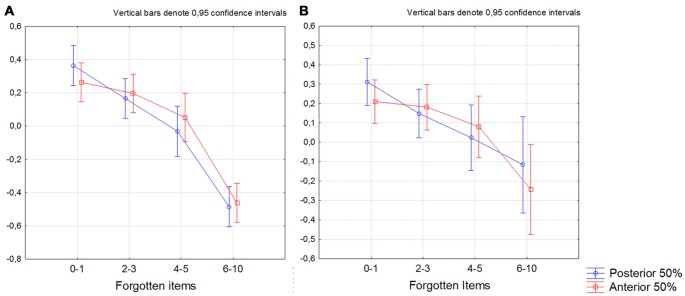
Differences between participants that forgot 0–1. 2–3. 4–5 and 6–10 items in the bilateral anterior and posterior 50% of the subiculum. The summarized volume of left+right 50% of posterior (blue line) and anterior (red line). X-axis denotes number of forgotten items. The y-axis denotes the volume of the anterior and the posterior 50% of the subiculum. (A) All participants, (B) participants with no cognitive decline on neuropsychological test (subjective cognitive decline (SCD)+cognitively normal (CN)). The model is further including gender as factor and age and intracranial volume (ICV) as covariates.